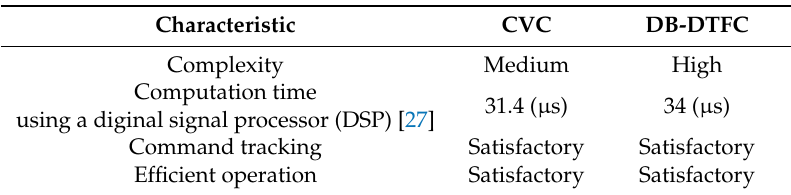
Table 1. Comparison of CVC (current vector control) and DB-DTFC (deadbeat-direct torque and flux control) based on results in Figure